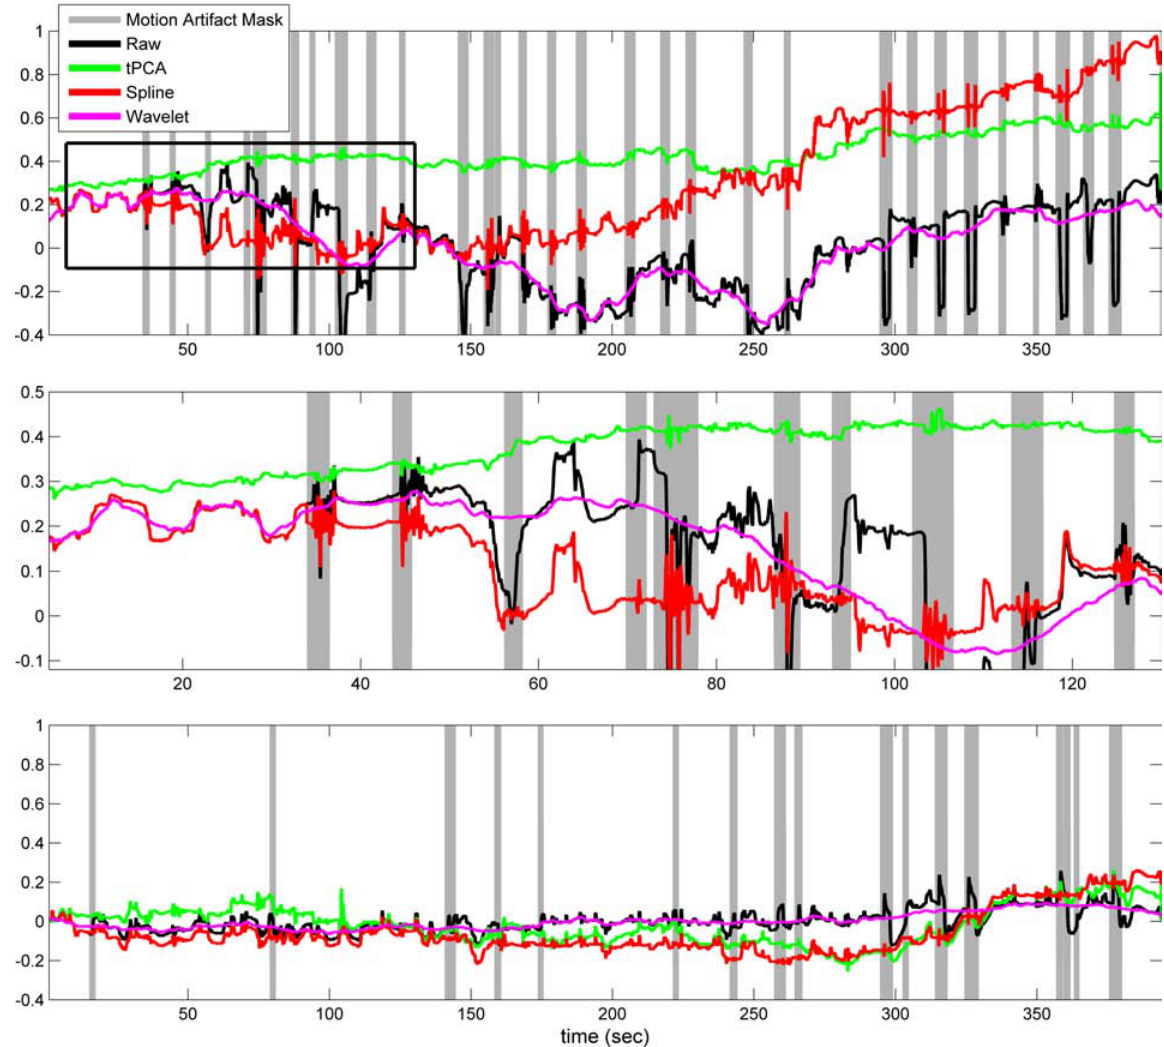
Fig. 2. Optical density change at 690 nm for a channel from the velcro-based probe (top panel) and from the collodion-¯xed probe (bottom panel) for one subject with no synthetic HRF added (black: unprocessed data; green: tPCA corrected data; red: spline interpolation corrected data; pink: wavelet-based ¯ltered data). Inset box is zoomed in the middle panel. The gray-shaded areas show the motion artifact mask identi¯ed in the corresponding channel